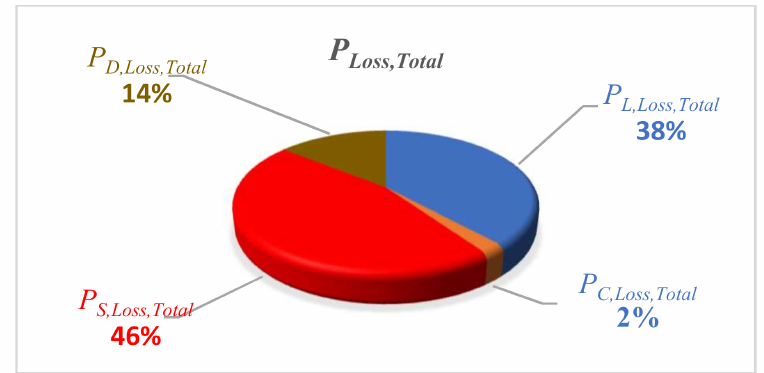
Figure 36. Loss breakdown